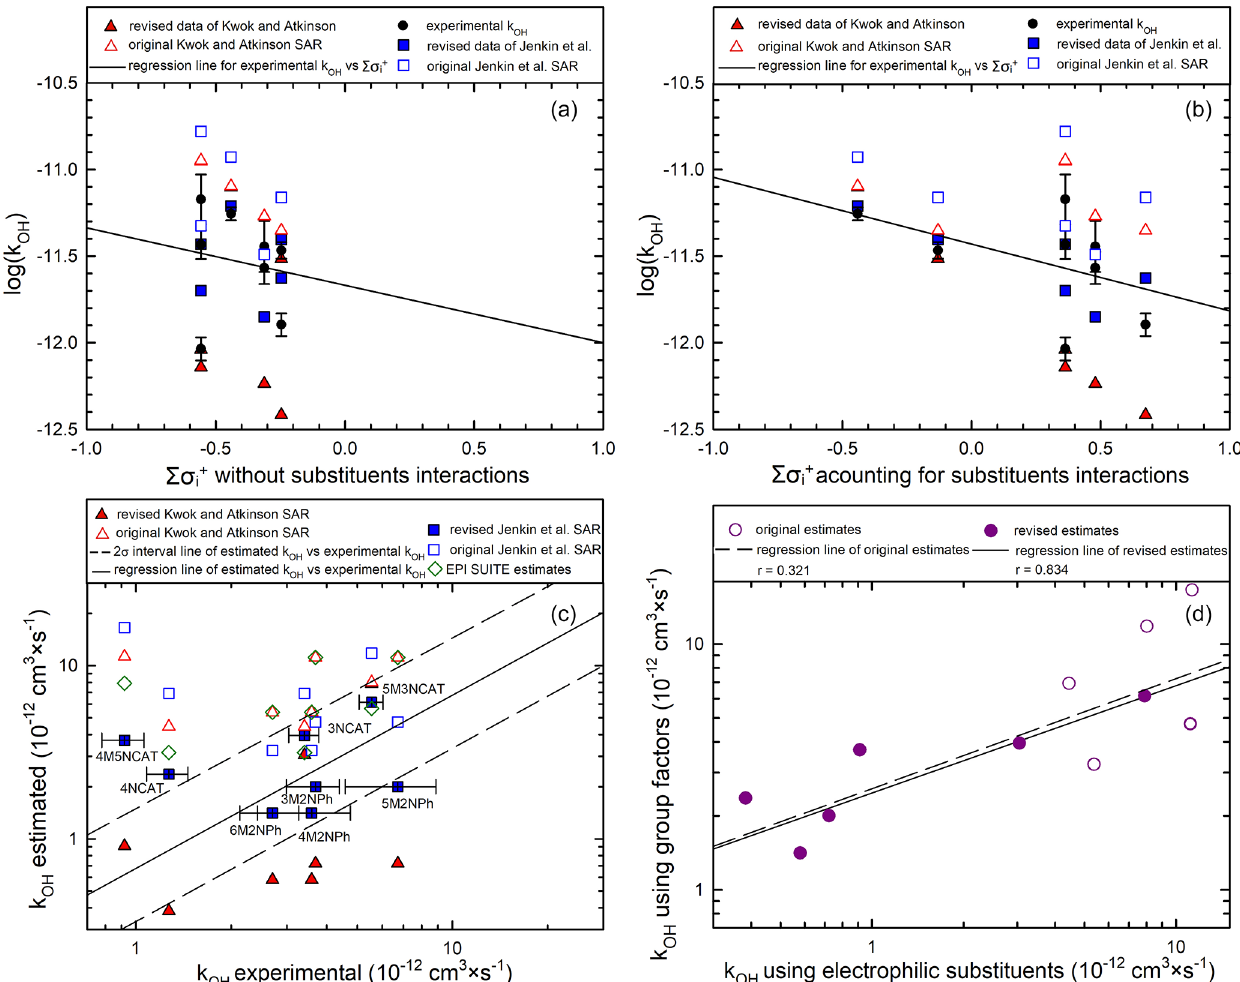
Figure 8. Correlation analyses between the experimental, the original estimated, and the revised estimated OH gas-phase rate coefficients of nitrophenols and